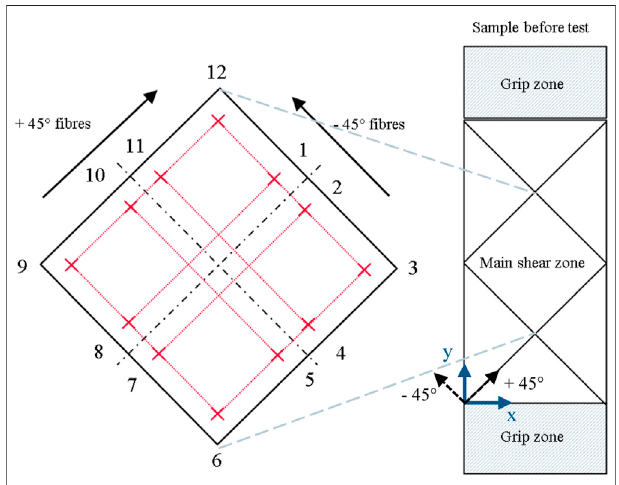
FIGURE 4 | Schematic of marker positions on bias extension sample for 2D DIC tracking.